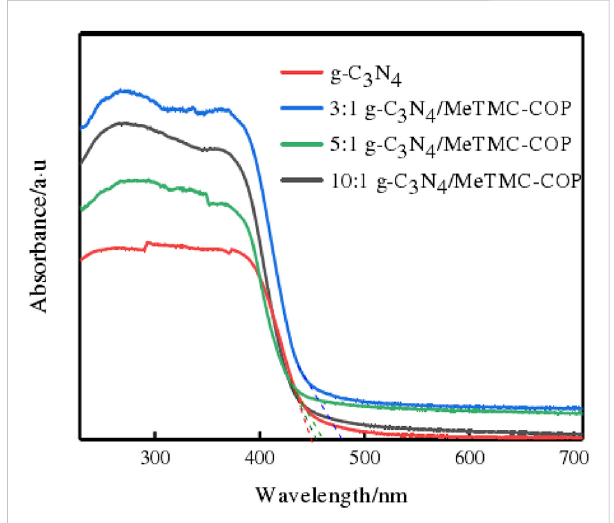
FIGURE 7 PL spectra of g-C 3 N 4 and g-C 3 N 4 /MeTMC-COP at different ratios.